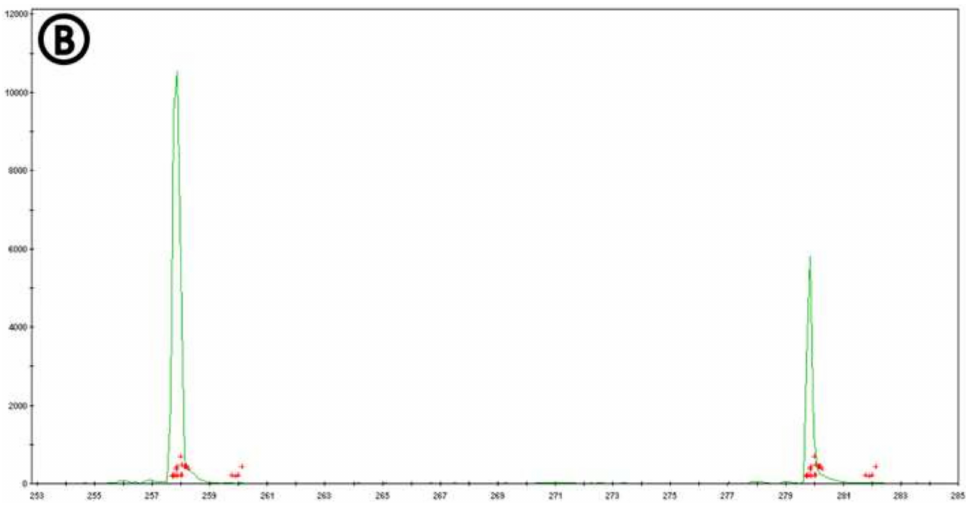
Figure 1. The results of allele scoring obtained from the primer labelled with a fluorescent dye, VIC (green) in GeneMarker ver.2.2.0 (SoftGenetics, State College, PA, USA); GeneScan ™ 600 LIZ (Applied Biosystem, Foster City, CA, USA) was used as the internal size standard (orange); some artefactual peaks are indicated as the red crosses. (A): microsatellite profile with no evidence of outcrossing (a single allele; haploid microsatellite profile), (B): microsatellite profile with evidence of outcrossing (two di ff erent sizes of alleles; diploid microsatellite